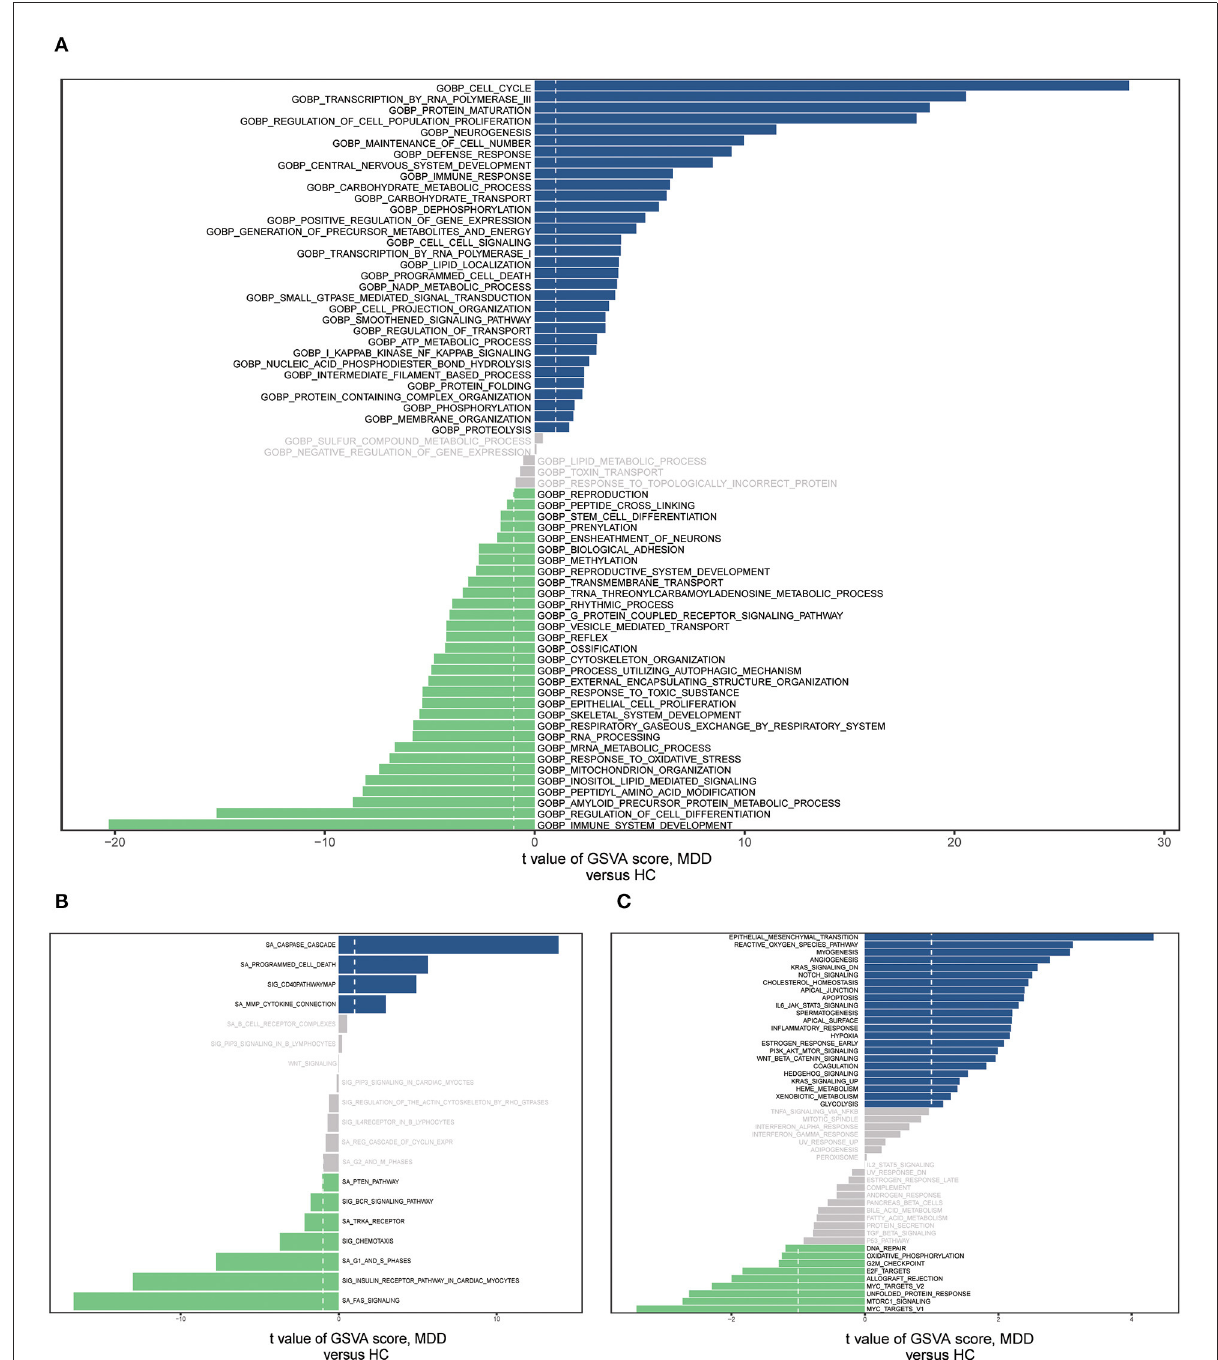
FIGURE8 The gene set variation analysis (GSVA) for two groups based on the GSE98793 database. (A) Bar graph depicting “GO” pathway scores computed by the GSVA. (B) Bar plot of “KEGG” pathway score calculated by GSVA. (C) Bar plot of “Hallmark” pathway score calculated by GSVA.